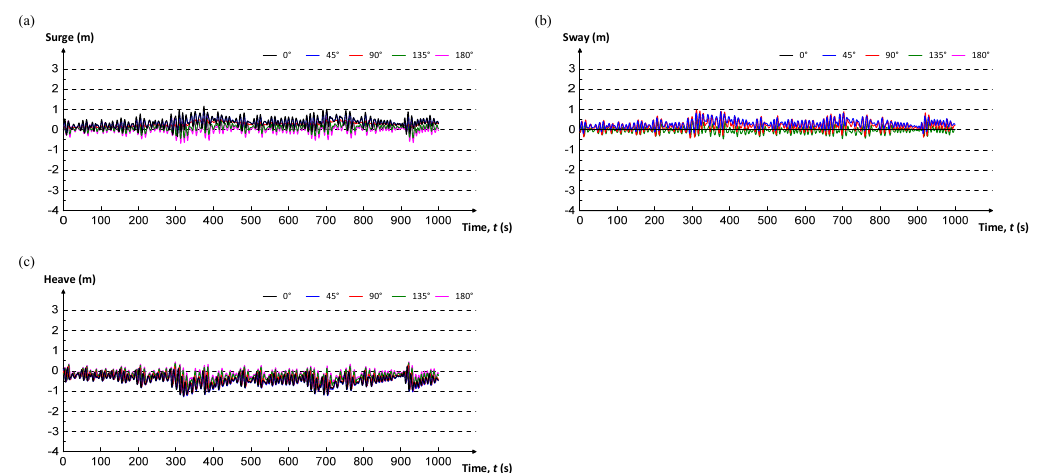
Figure 17. Translational responses against different approaching wave directions under normal wave conditions. ( a ) Surge; ( b ) Sway; ( c ) Heave.